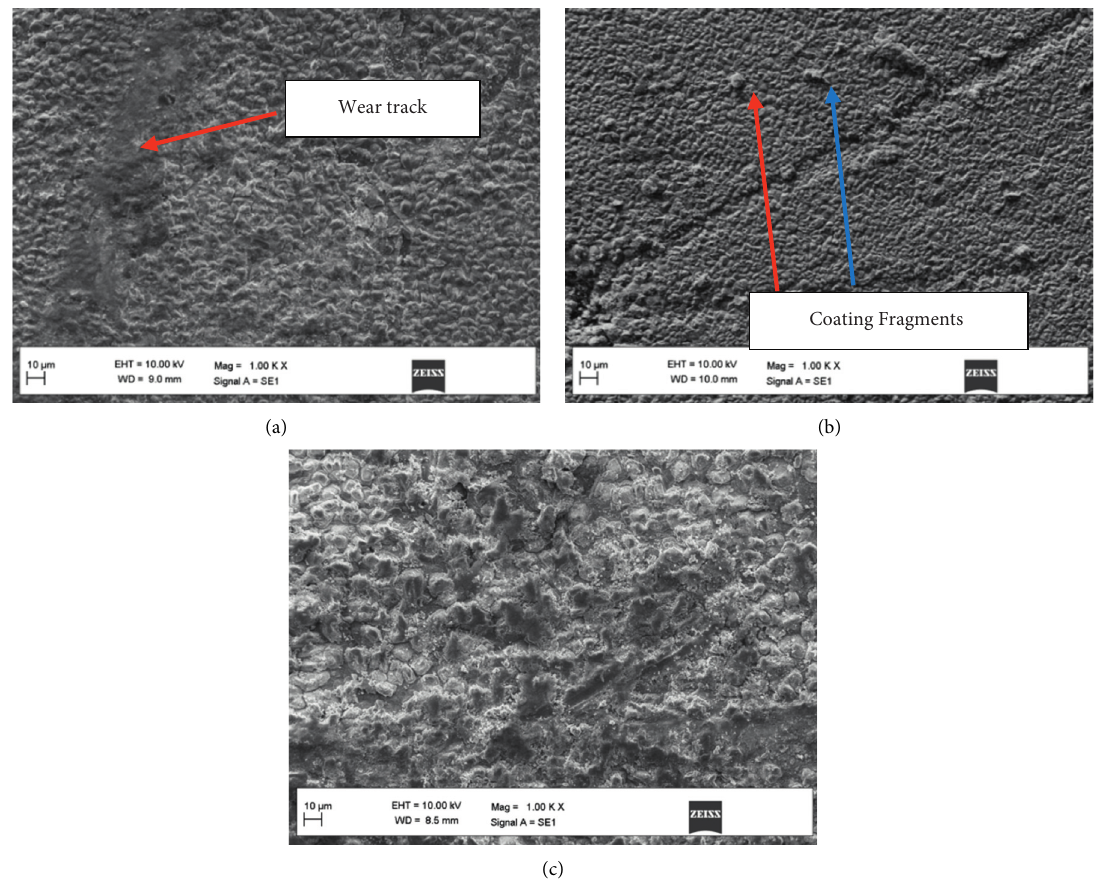
Figure 9: SEM micrograph of wear track morphology on the worn-out surface obtained at 0.5m/s sliding speed and 1kgf normal load for (a) Al 2 O 3 +3wt%TiO 2 +1wt% CNTs reinforced coating, (b) Al 2 O 3 +3 wt%TiO 2 +3 wt% CNTs reinforced coating, and (c) Al 2 O 3 +3wt% TiO 2 +5 wt% CNTs reinforced coating.